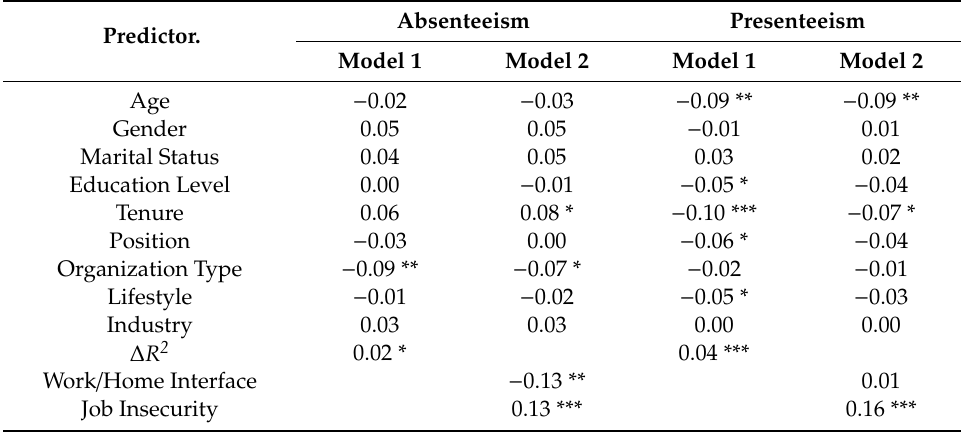
Table 3. Hierarchical multiple regression results of job stressors on economic outcomes.